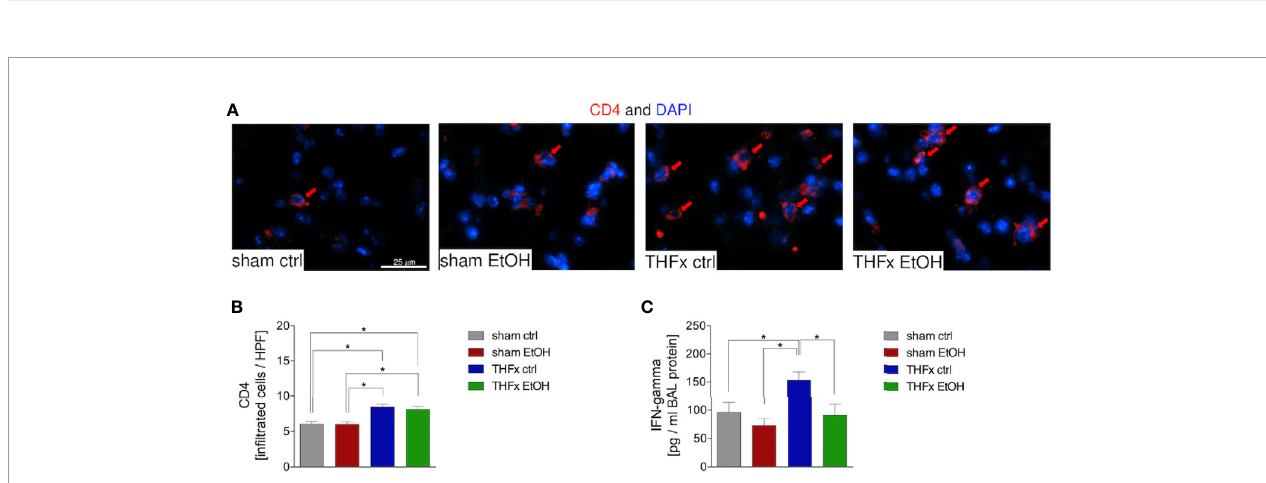
FIGURE 5 | Impact of acute ethanol intoxication (EI) on the b -catenin – E-cadherin co-expression after femoral fracture (Fx) and hemorrhagic shock (HS, THFx respectively). The animals received an intragastric gavage of either sodium chloride (ctrl, n = 14) or ethanol (EtOH, n = 14) to simulate an acute intoxication with alcohol. Two hours before the initiation of experiments, the animals in trauma groups underwent an Fx ( via osteotomy after the placement of an external fi xator) and a pressure-controlled HS with subsequent resuscitation with Ringer ’ s solution (THFx) via catheterized femoral artery ( n = 14). Sham groups underwent catheterization and received an external fi xator, but THFx was not induced ( n = 14). Twenty-four hours after the end of the experiment, mice were euthanized, and sampling was performed. Expression of b -catenin and E-cadherin as well as their co-localization were determined. (A) Representative immuno fl uorescent staining of b -catenin in green (green arrows, Alexa Fluor 488) and E-cadherin in red (Alexa Fluor 568), and overlay (orange arrows) are represented. (B) Quanti fi cation of the b -catenin – E- cadherin co-expression at junctions is shown. (C) Quanti fi cation of b -catenin expression at the membrane, (D) b -catenin expression in the cytosol, (E) E-cadherin at the membrane, and (F) E-cadherin in the cytosol in lung sections of mice is depicted. Data are presented as mean ± standard error of the mean; n = 7 in all groups, * p < 0.05 between indicated groups.